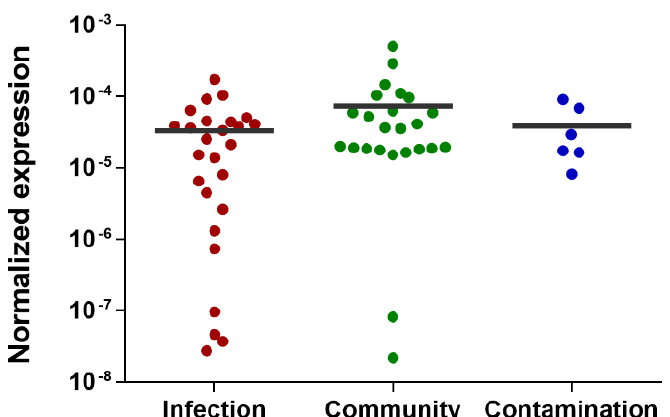
Figure 4. Evaluation of the discriminative potential of the gene SERP2441 in a wide collection of isolates. This evaluation was performed 2 h after incubation with horse blood in a collection of 56 isolates. Of note, the isolates belonging to the “contamination” group are isolates collected from either contaminated samples or the skin of patients or staff. The horizontal line represents the grand mean of the transcription level of all isolates ( n = 2 to 3 technical qPCR replicates). Statistical differences among groups were analyzed with one-way ANOVA and Tukey ´ s multiple comparison